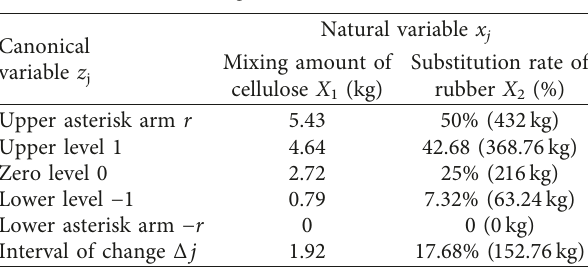
Table 5: Coding schedule of level of factor.